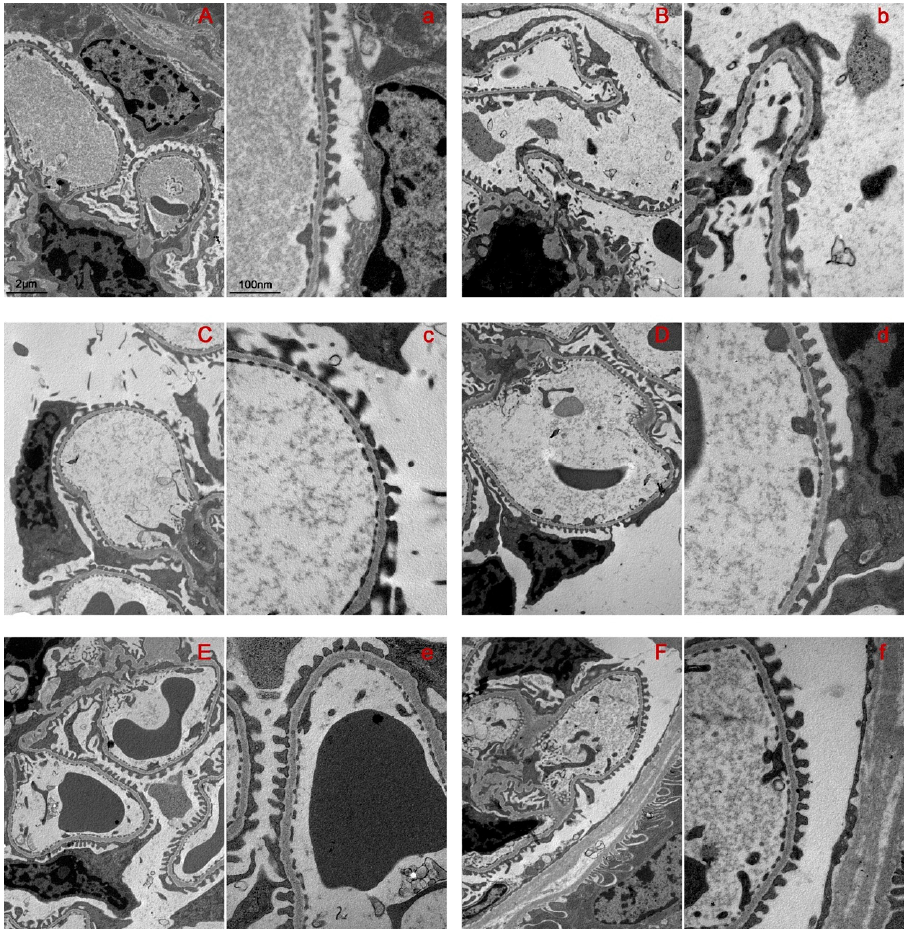
Figure 4. Effect of bilastine on glomerular morphology. Representative electron microscope micrographs showing ultrathin podocyte sections. Micrographs at 10 K (Capital letters) and 25 K (Lower case letter) magnification are representative of 5 animals/group. A and a = CTRL; B and b = STZ; C and c = STZ + bilastine 1 mg/kg; D and d = STZ + bilastine 3 mg/kg; E and e = STZ + bilastine 1 mg/kg; F and f = STZ + bilastine 1 mg/kg.